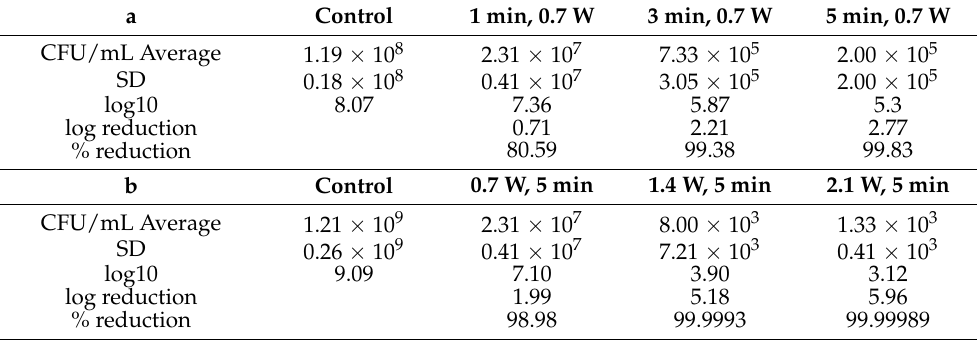
Table A1. Bactericidal effect of aPDT/PACT using ICG-Nano/c on planktonic E. faecalis . Actual values of data indicated in Figure 1 are shown. ( a ) Bactericidal effect with irradiation of different dura- tions. The diode laser was applied with 0.7 W peak power output without air-cooling. ( b ) Bactericidal effect with different irradiation powers. The laser operated for 5 min without